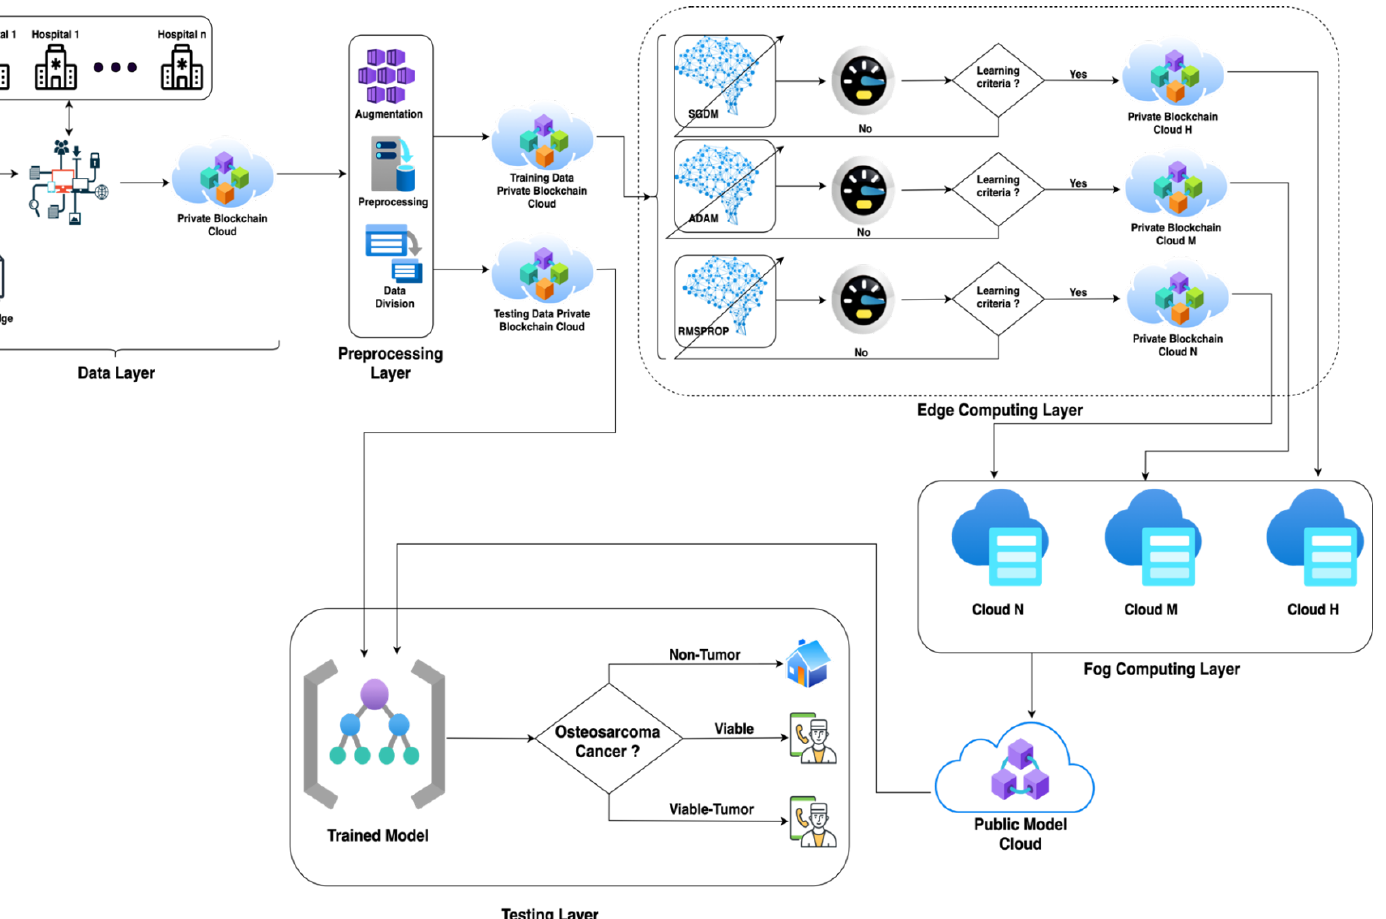
Figure 1. IoMT-based proposed model for the prediction of osteosarcoma cancer using transfer learning empowered with blockchain security, fog computing, and edge computing.